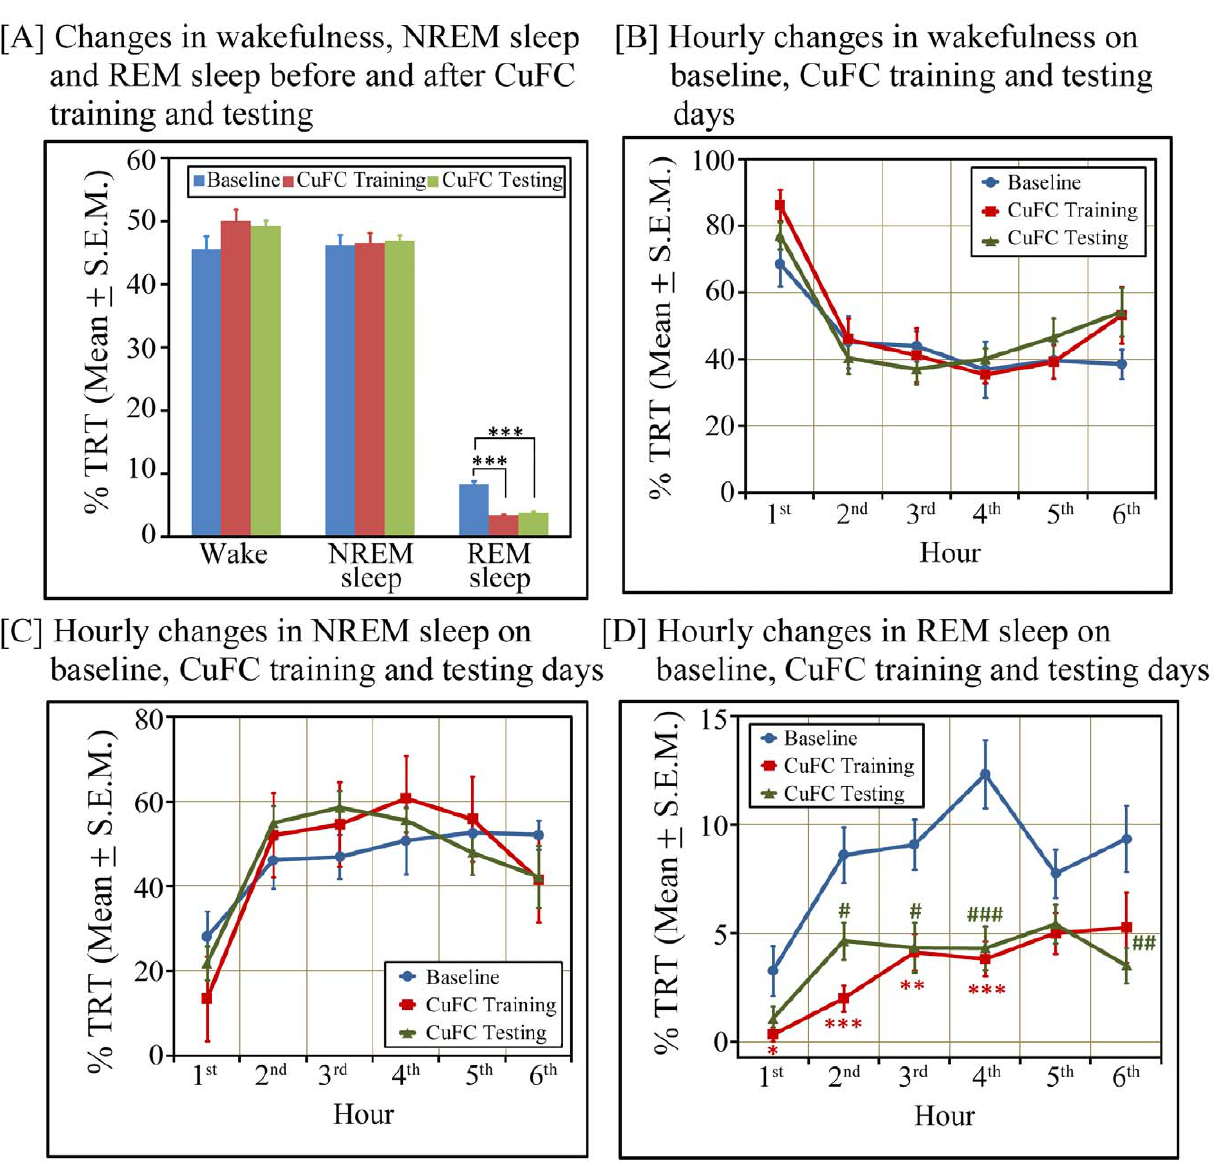
Figure 3. Changes in sleep-wake architecture (out of total recording time) after cued-fear conditioning during lights-on phase. [A] Percent changes in wakefulness, NREM sleep and REM sleep amount after CuFC training and testing compared to baseline day. Out of total recording time, % wakefulness and % NREM sleep amount on CuFC training and testing days did not change, however, % REM sleep amount significantly decreased on CuFC training (p , 0.001; F (1,15) =90.69) and testing (p , 0.001; F (1,15) =82.63) days compared to baseline day. Hourly percent time spent in [B] wakefulness [C] NREM sleep and [D] REM sleep during the lights-on phase. REM sleep amount significantly decreased on training day (except 5 th and 6 th hours) and testing day (except 5 th hour). * signifies changes in REM sleep amount on CuFC training day, while # signifies changes in REM sleep amount on CuFC testing day compared to the time matched hour on baseline day. Significance level: *= p , 0.05; **= p , 0.01; ***= p , 0.001; # = p , 0.05; ## = p , 0.01; ### = p ,